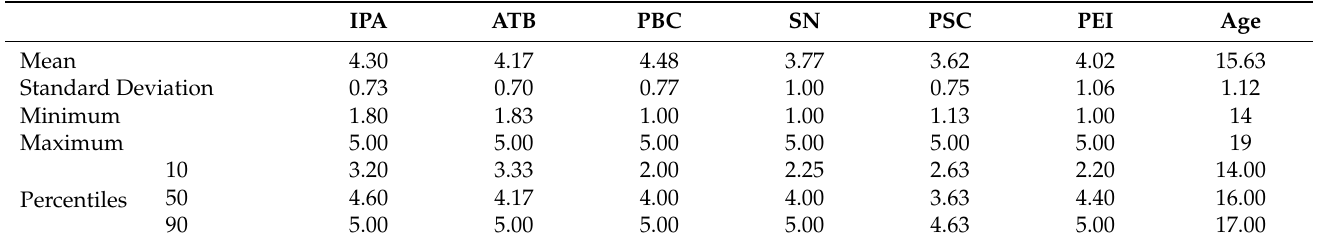
Table 3. Means, Standard Deviation, and percentiles of 10,50, and 90 of the